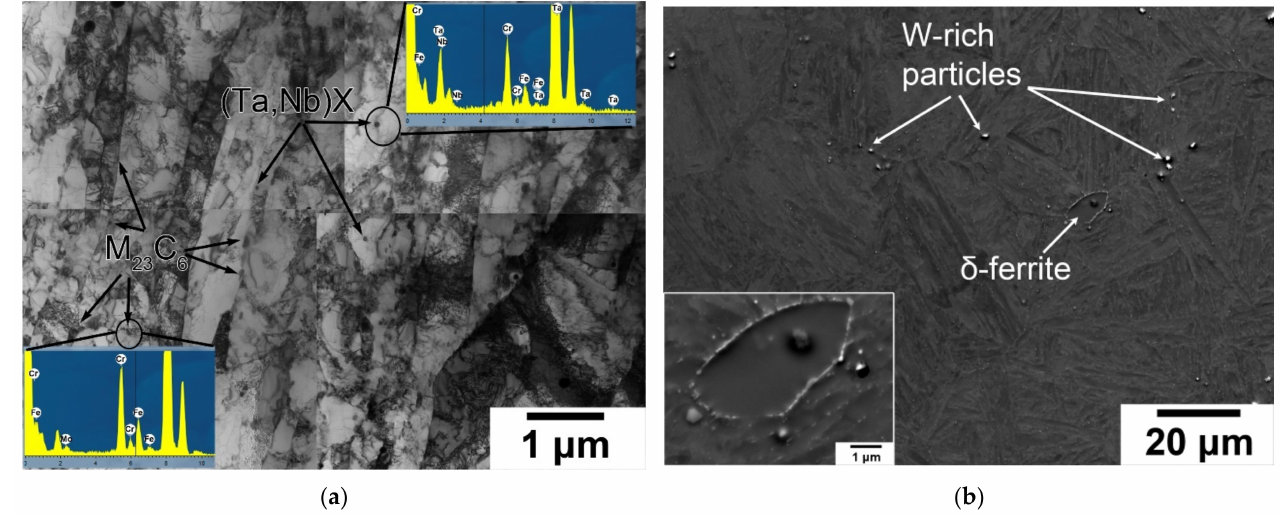
Figure 8. ( a ) TEM and ( b ) SEM images of the TMLS after the TMP. The main difference in the TMLS produced by CHT and TMP consisted in the dis- persion of MX carbonitrides. After CHT, the MX carbonitrides were enriched by Ta and Nb with the ratio of Ta: Nb as 13: 1 and their average size comprised about 50 ± 5